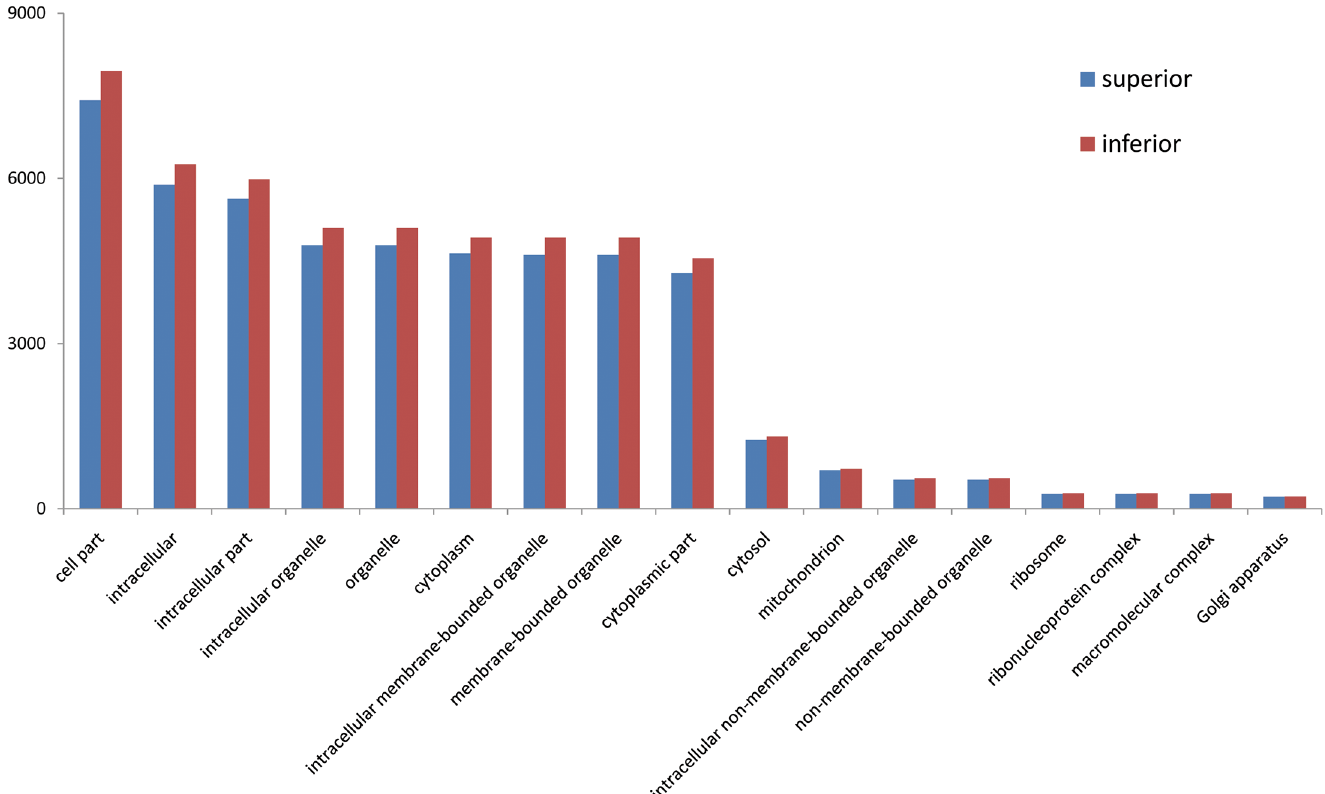
Fig 2. Gene Ontology (GO) enrichment analysis. The genes expressed in superior grains were taken as input list, and genes expressed in inferior grains were background list. All categories were classified according to their biological process, cellular component and molecular function. The blue bar indicates percentage of genes obtained in this study in each GO category, and the green bar indicates percentage of all annotated rice genes in each GO category.